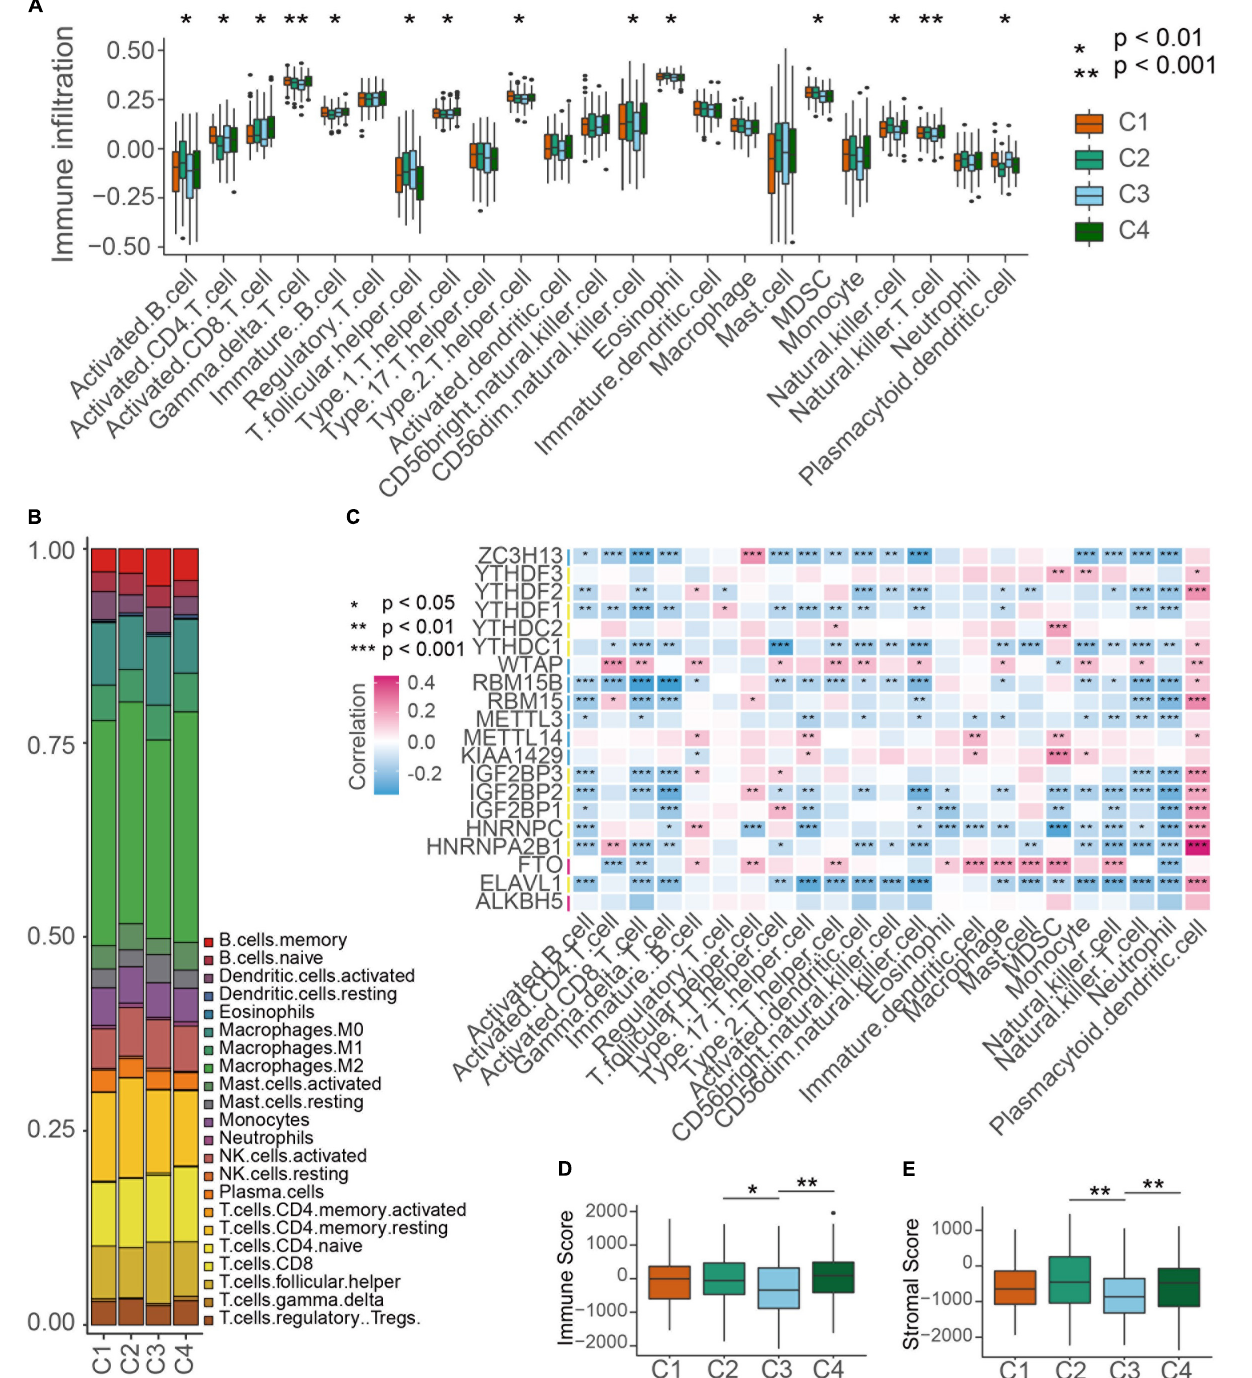
Frontiers in Genetics |